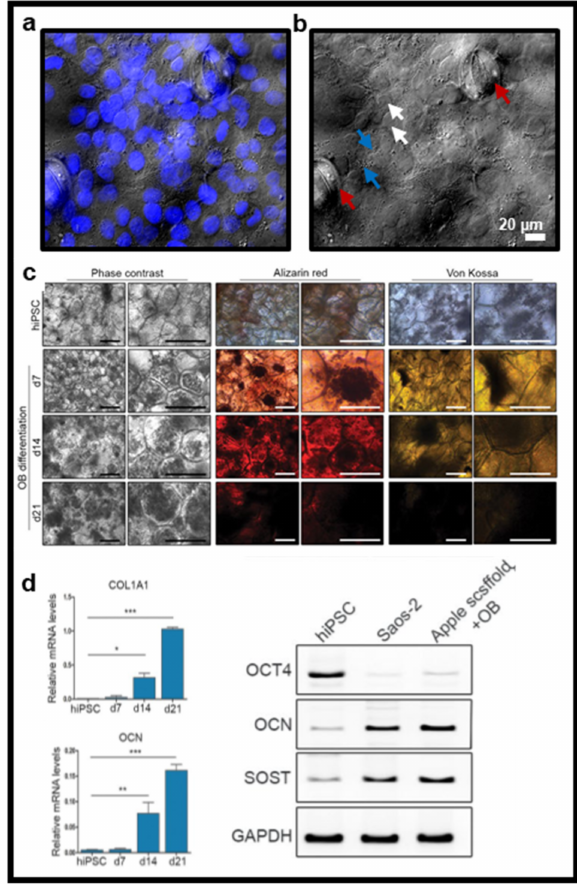
Figure 3. ( a ) Example of lung epithelial cells (nuclei stained with DAPI) seeded on the surface of a decellularized spinach leaf scaffold. ( b ) Brightfield image of plant scaffold alone shows plant features such as stomata (red arrow) and confirms cell attachment with the presence of cell shape imprints (white arrow) in the scaffold and points of cell attachment (blue arrow). Data generated by authors for illustrative purposes for this review using epifluorescence microscopy. ( c , d ) Osteoblastic differentiation of hiPSCs on 3D plant scaffold. Phase contrast images, Alizarin Red S stain and von Kossa stain before and after differentiation. Levels of osteocalcin and type I collagen mRNA expressed by hiPSCs before and after osteoblastic differentiation and expression levels of OCT4 , OCN , and SOST mRNA after osteoblastic differentiation. Reproduced, from Lee et al.